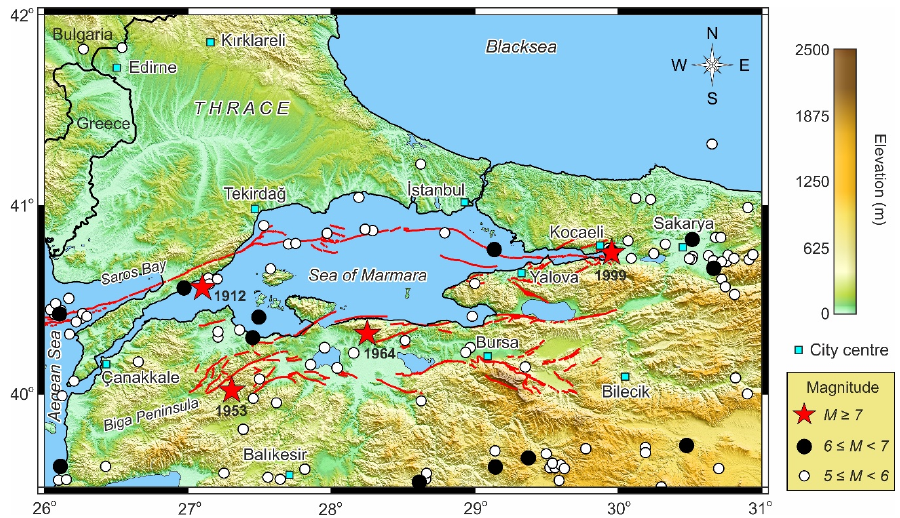
Figure 2. The epicenter distribution map of the Marmara Region in the instrumental period. The map was produced using the GMT software (Wessel and Smith, 1995